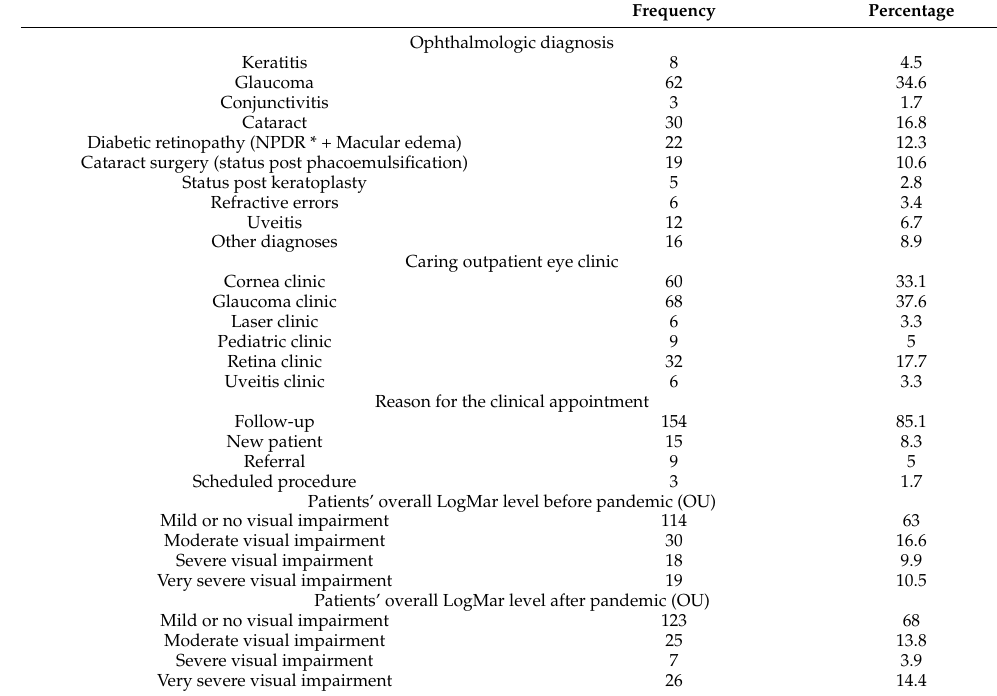
Table 1. Descriptive analysis of the patients’ ophthalmologic medical history